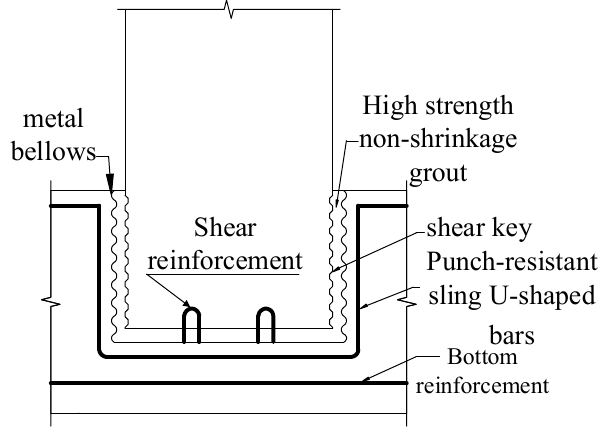
Figure 2. Improved socket type.